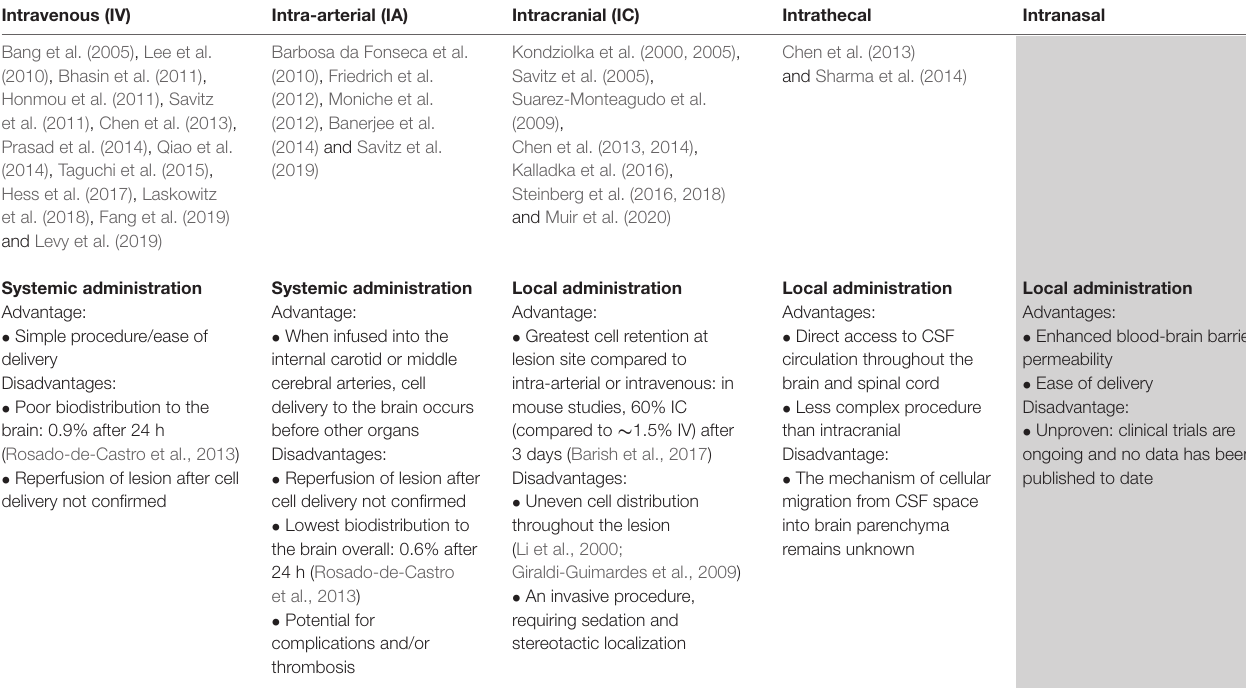
TABLE 2 | Routes of administration of completed stem cell trials for ischemic stroke. Intravenous (IV) Intra-arterial (IA) Intracranial (IC) Intrathecal